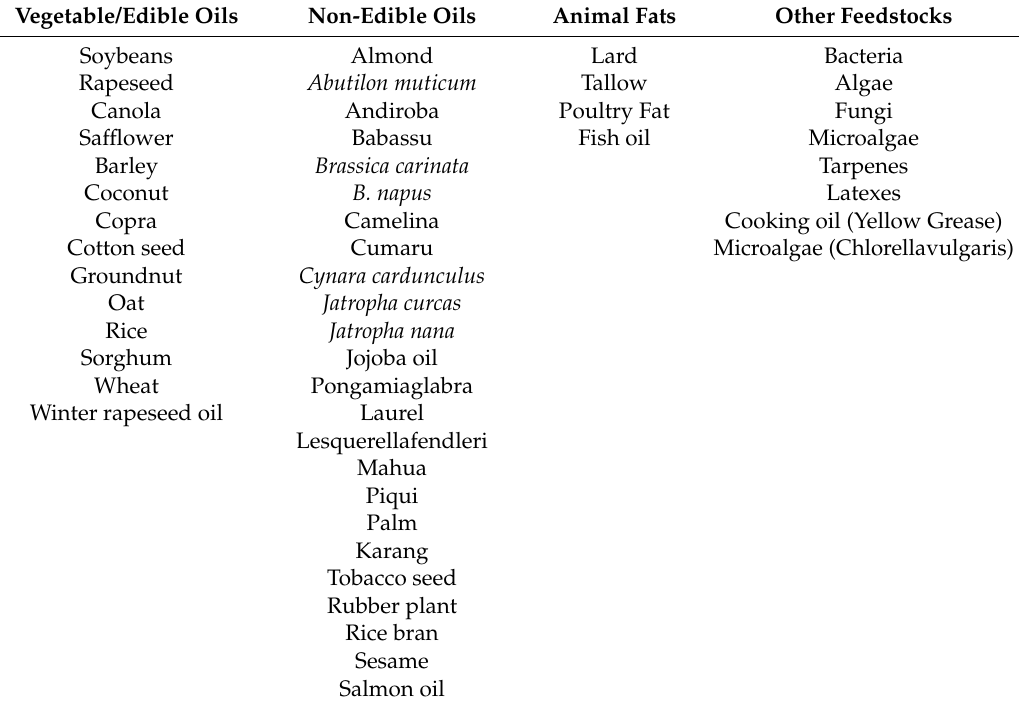
Table 1. Different feedstocks for biodiesel